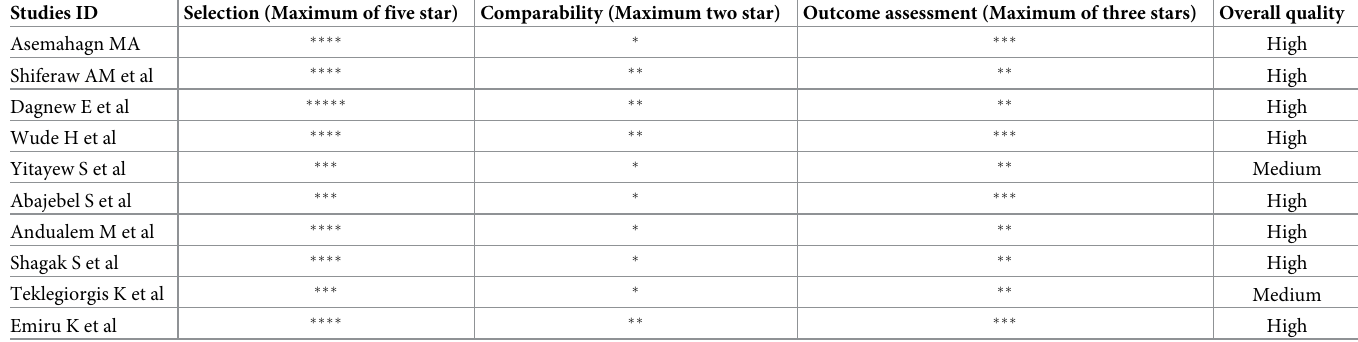
Table 2. Quality assessment of primary studies included in the meta-analysis of utilization of routine health information and associated factors among health work- ers in Ethiopia, 2020. Studies